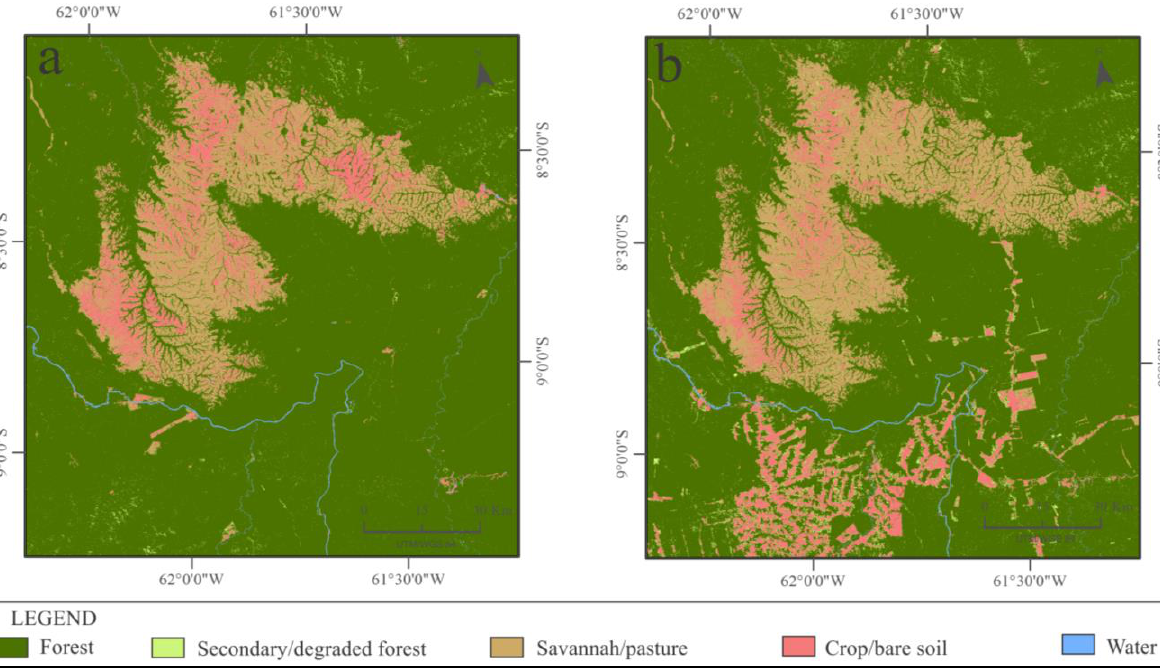
Figure 2. LULC classification of 1984 (a) and 2010